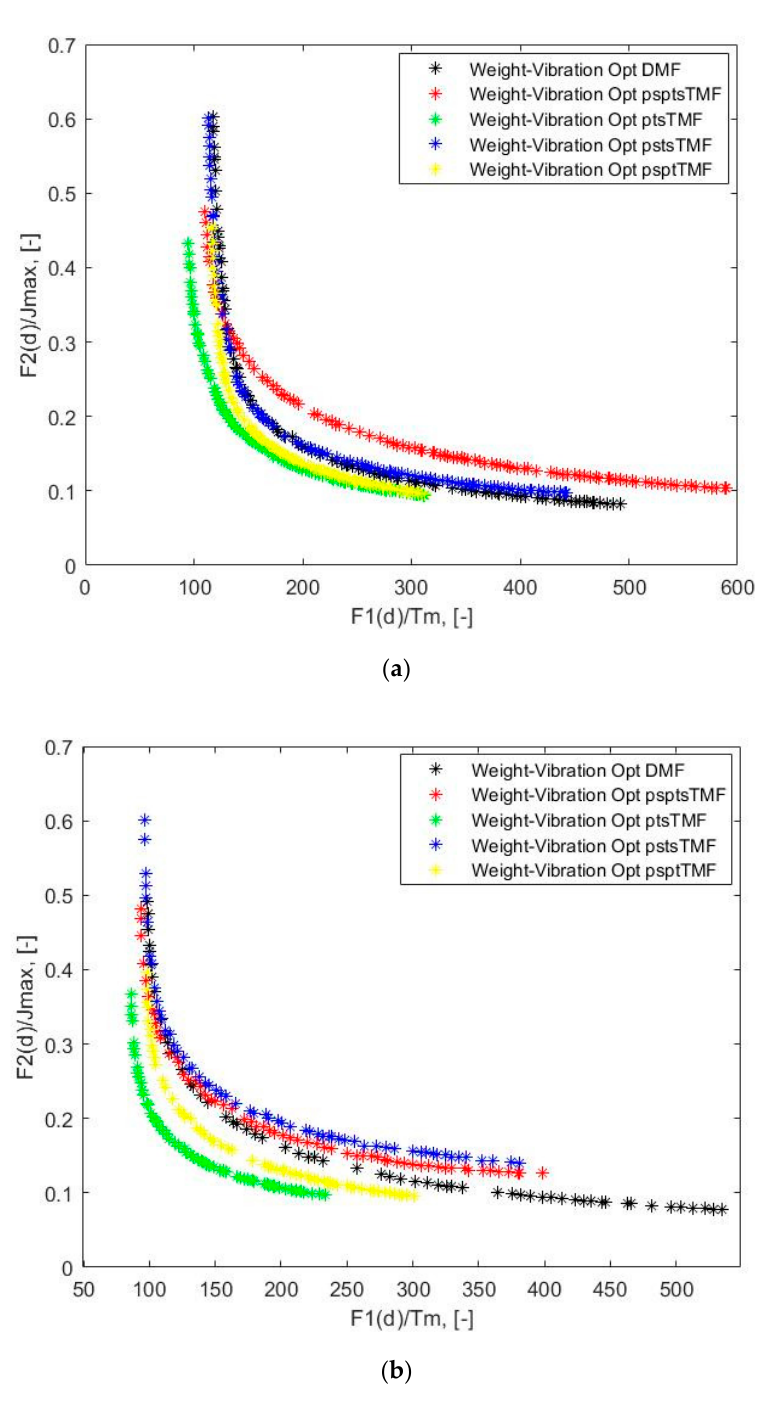
Figure 3. Pareto fronts for the drivetrain with the TMF in operating engine speed range 600 rpm ≤ n e ≤ 2000 rpm: ( a ) for T m = 300 Nm, a e = 500 Nm; ( b ) for T m = 3000 Nm, a e = 3000 Nm; J max = 4.05kg m 2 . DMF, dual mass